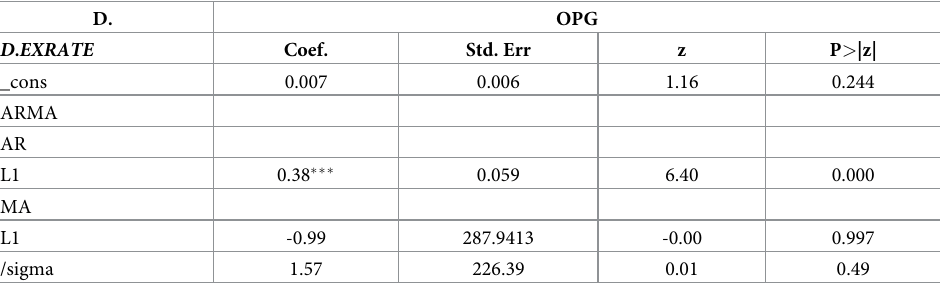
Table 4. Estimation of ARIMA (1,0,0)